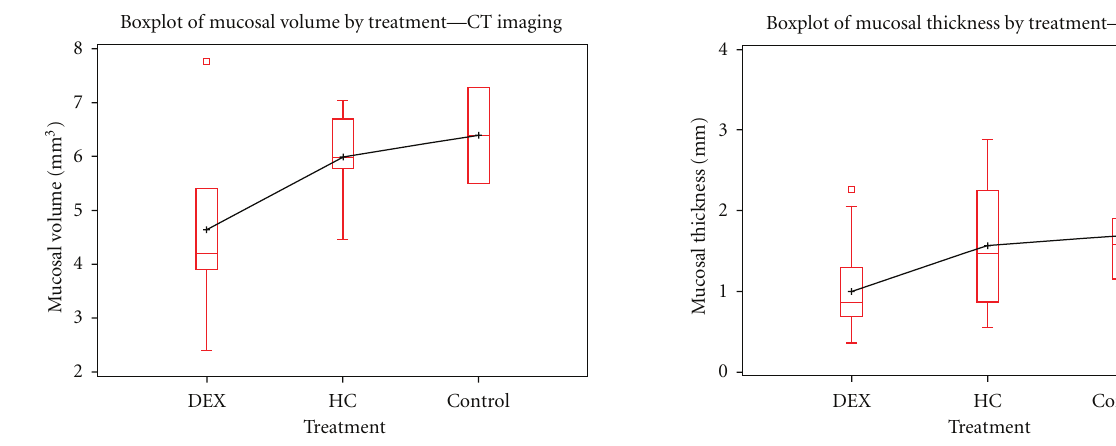
Figure 4: Boxplot of mucosal thickness by CT Imaging. Findings by CT also reveal that DEX treated chinchillas had less MT thickness when compared to the other groups. While the overall trend is comparable to the MRI and Histology results, the CT findings are not statistically significant at an α = 0 . 05 level due to the small sample size ( N = 14, χ 2 = 0 . 9762, P -value = 0 . 6138). CT measures of MT were based on mucosal volume (mm 3 ).